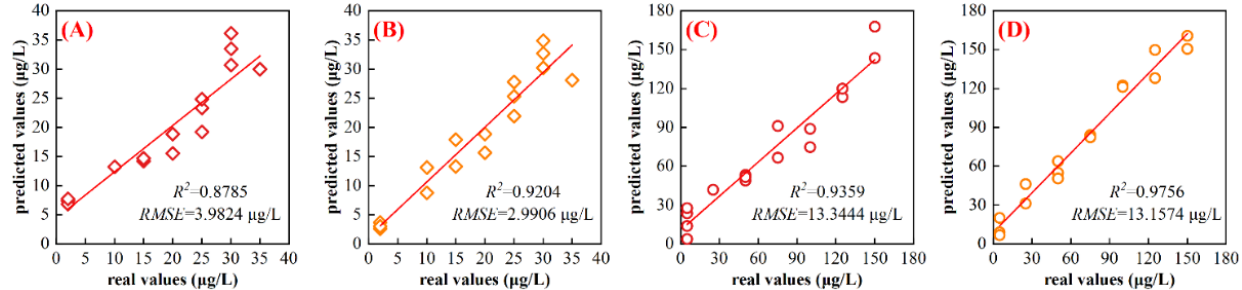
Figure 9. PSO-SVR model results for Cd 2+ ( A , B ) and Pb 2+ ( C , D ) concentration detection in the validation dataset. (Diamond scatters represent Cd 2+ concentrations, circular scatters represent Pb 2+ concentrations, red scatters represent the model input as A manu , orange scatters represent the model input as A algo ).